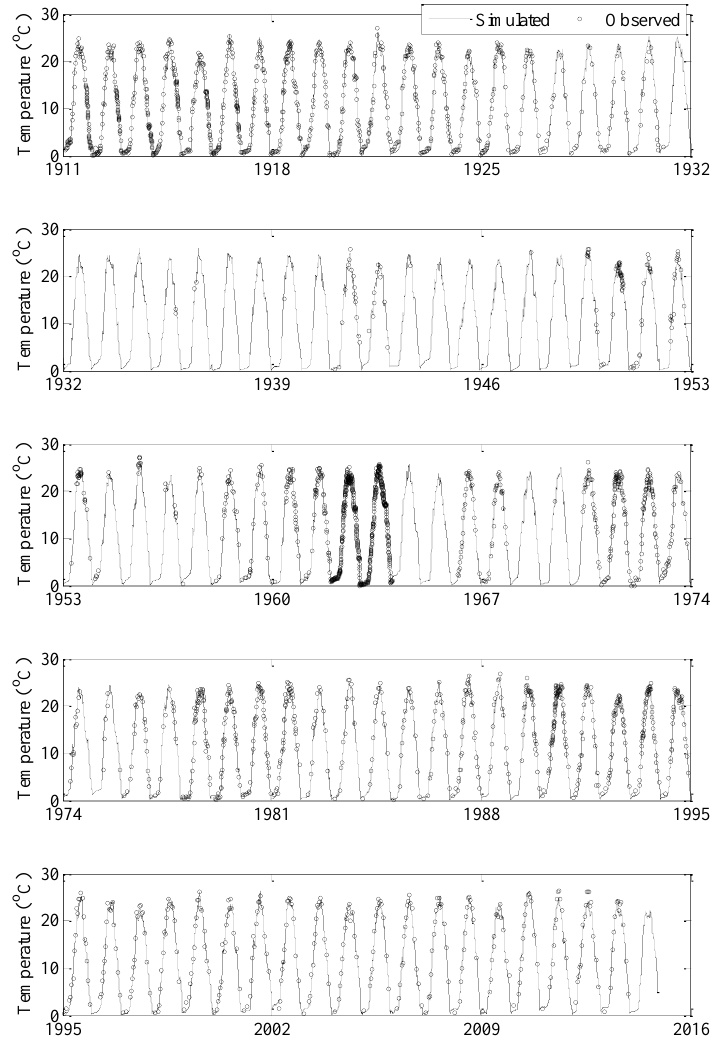
Figure 5. Time series of the simulated and observed volume-weighted near-surface (epilimnetic) temperature (0–10m) from